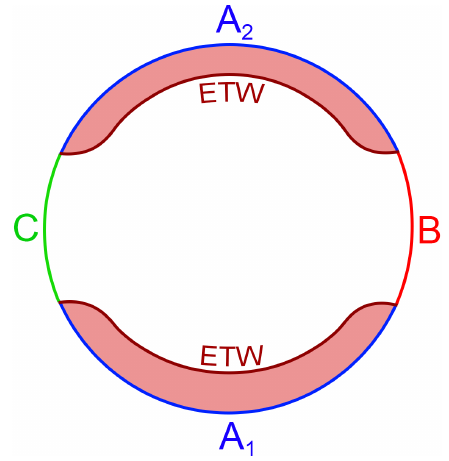
Figure 2 . Schematic representation of the λ 2 = 0 slice in our original coordinates for the infinite cylinder with slits when a large region A is projectively measured on a Cardy state with large positive boundary entropy. By choosing a sufficiently large positive value for the ETW brane tension (i.e. T . T c ), the slice can remain connected even if | A | (cid:29) | A c | . This is possible because the holographic theory living on the boundary is a large- N gauge theory. The connectedness of the slice in this setup is evidence that the LPM teleports bulk information from A to A c